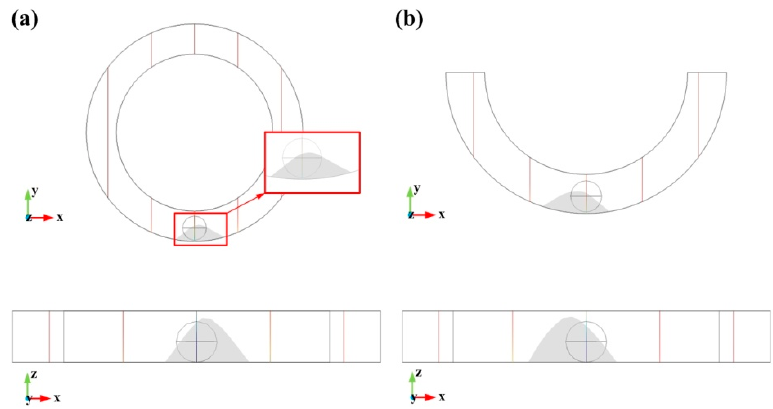
Figure 2. Results of the droplet deformation after 0.3 s time step: ( a ) is the entire annular groove result; ( b ) is the half annular groove result.